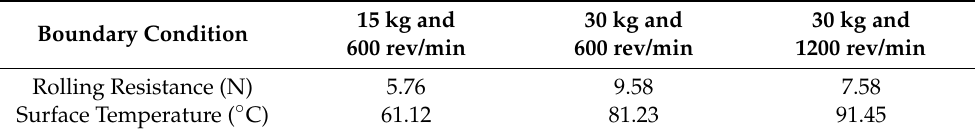
Table 4. Simulation data of RR and maximum steady-state surface temperature of the Lagrangian model under different rolling conditions.